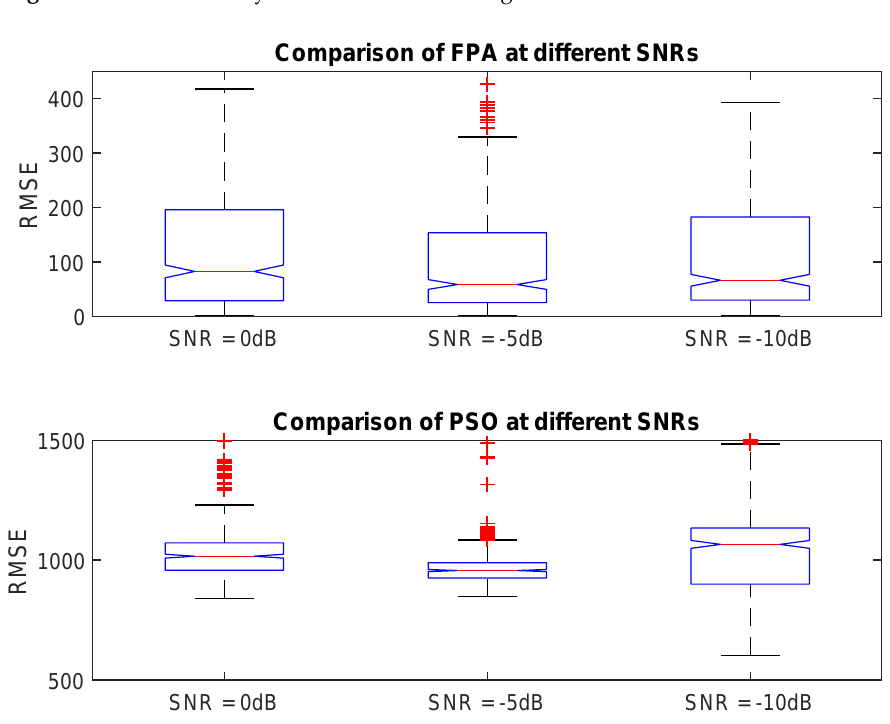
Figure 12. Variation analysis of RMSE for eleven